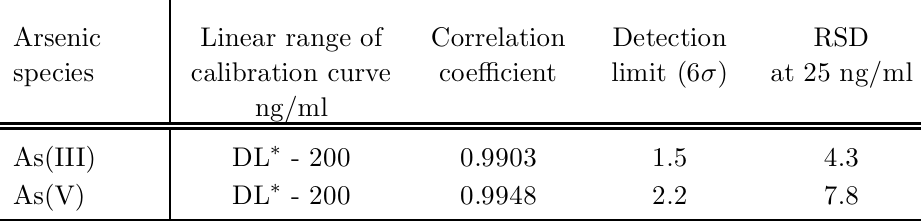
Table 2 Analytical characteristic obtained for arsenic species (n=10) for HPLC-HGAAS deter- mination.